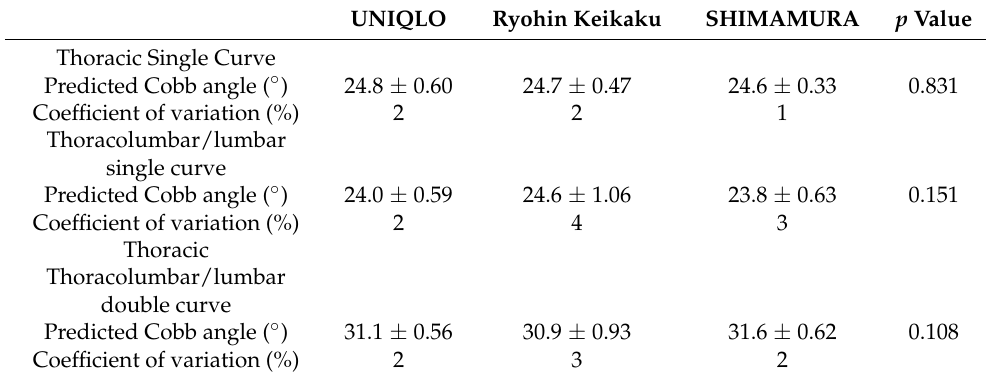
Table 1. Predicted Cobb angle and coefficient of variation in three black underwear types. UNIQLO